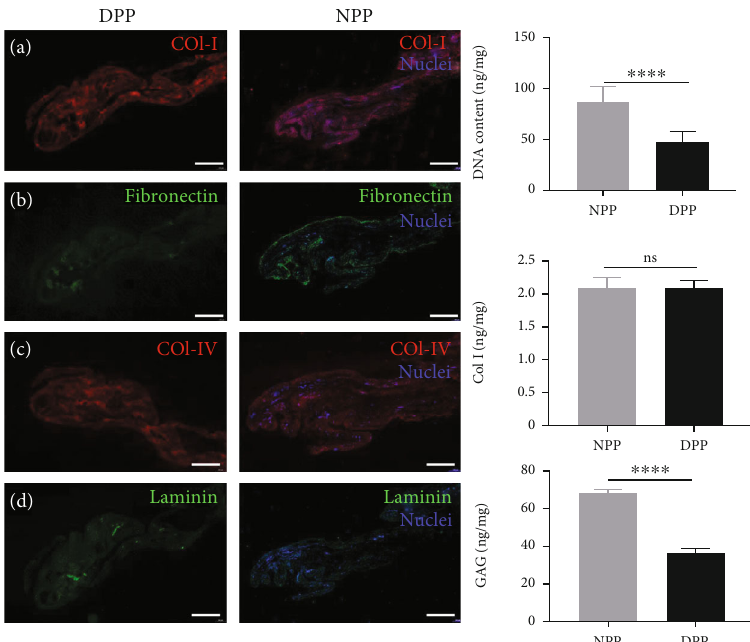
Figure 2: Component comparison of DPP and NPP. (a) Fluorescence staining of (A) type I collagen, (B) fi bronectin, (C) collagen IV, and (D) laminin in DPP and NPP. Nuclei were stained by DAPI ( scale bar = 50 μ m ). Comparison of DPP and NPP regarding (b) DNA content,